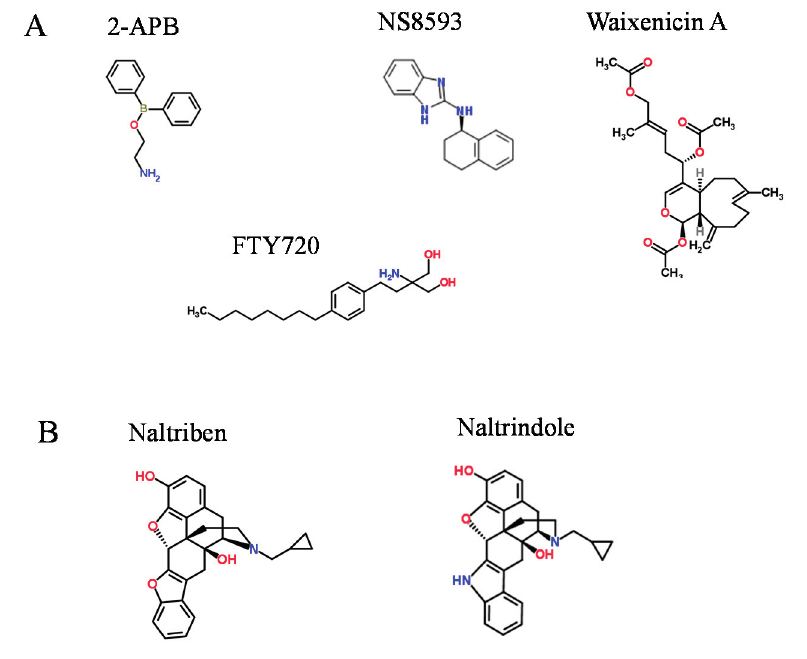
Figure 2. Chemical structures of modulators of the TRPM7 channel. ( A ) A subset of broadly used inhibitors of the TRPM7 channel; ( B ) A newly identified activator of the TRPM7 channel, naltriben, and the related inactive compound